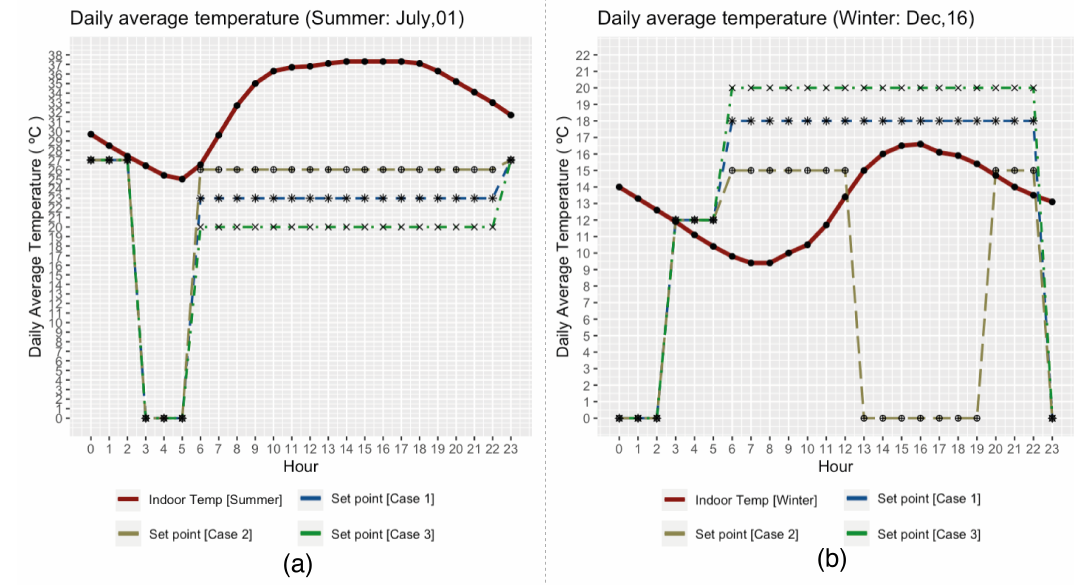
Figure 10. Indoor temperature in summer and winter and the setpoint for each case: ( a ) displays the indoor temperature for 16 December and the setpoints for each case, and ( b ) displays the indoor temperature for 1 July and the setpoints for each